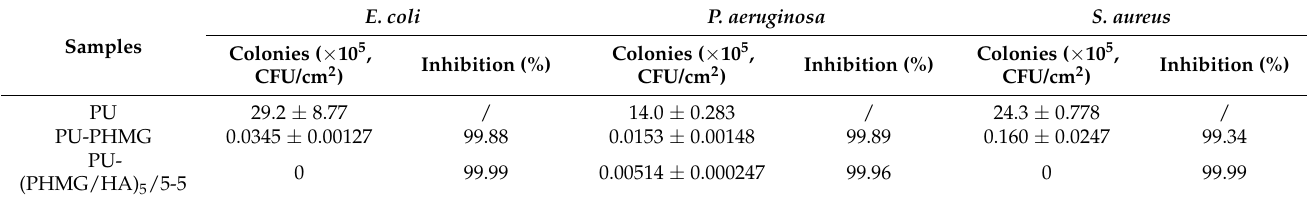
Table 3. Antibacterial test of films against E. coli , P. aeruginosa , and S. aureus . E. Samples